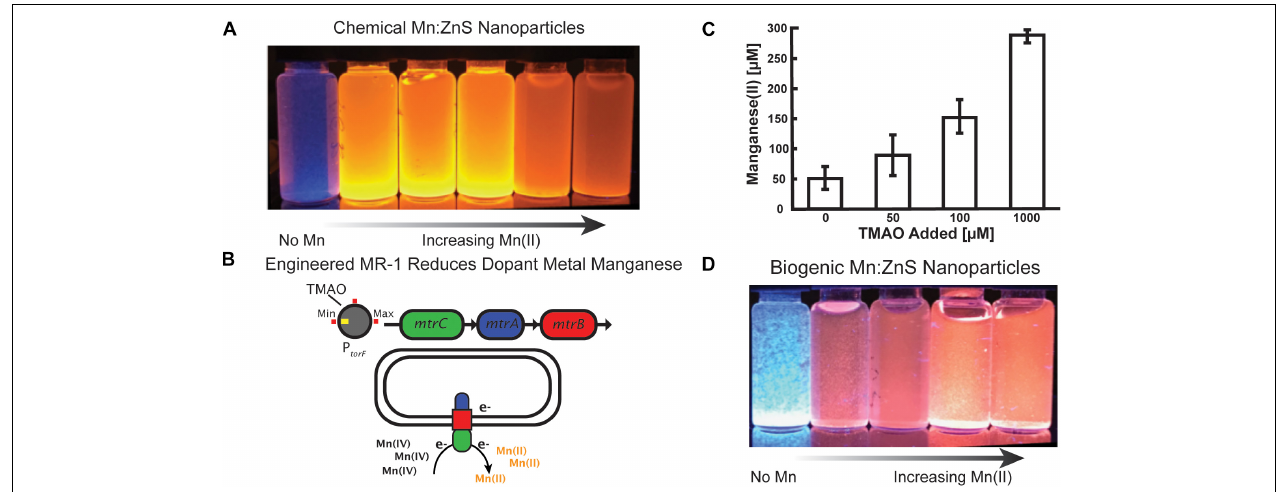
FIGURE 1 | Controlling manganese doping of zinc sulfide nanomaterials by engineered Shewanella oneidensis JG3631. (A) Chemical synthesis of Mn doped zinc sulfide nanoparticles, demonstrating that increased Mn doping alters the optical properties of the nanoparticles. (B) In engineered Shewanella MR-1, the TMAO inducer molecule regulates expression of the metal reducing cytochrome complex MtrCAB. MtrCAB performs extracellular reduction of metals. (C) Cultures of the engineered Shewanella produced Mn(II) concentrations proportional to the concentration of the TMAO inducer. Samples were collected from well mixed cell